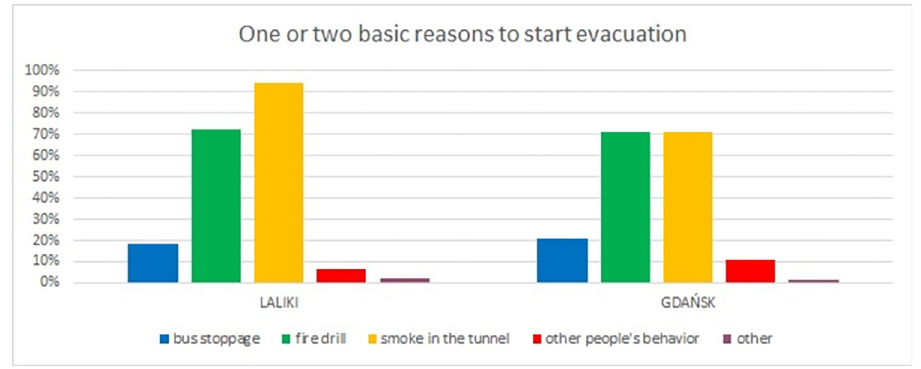
Fig 6. Survey results in question about reasons for decision to start evacuation (results from Experiment 1).